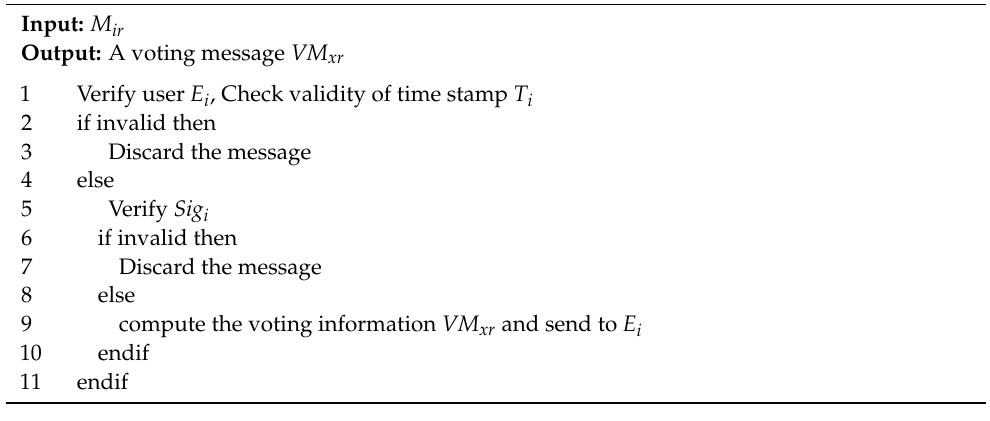
Algorithm 1 Voting procedure of neighbor subscribes E x